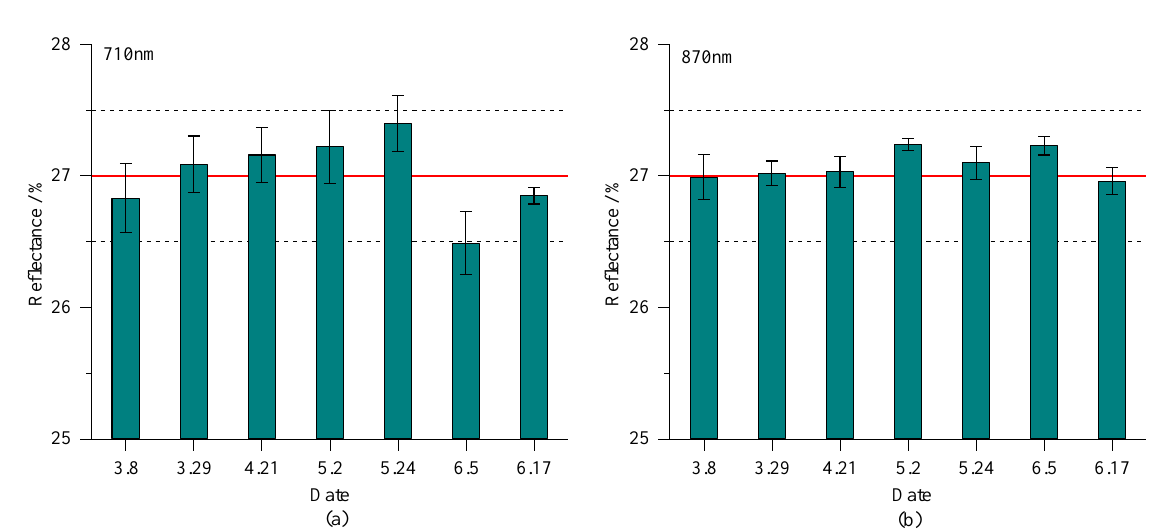
Figure 15. Reflectance of the 27% standard reflectance gray-scale target measured by the sensor on different dates. ( a ) 710 nm; ( b ) 870 nm.